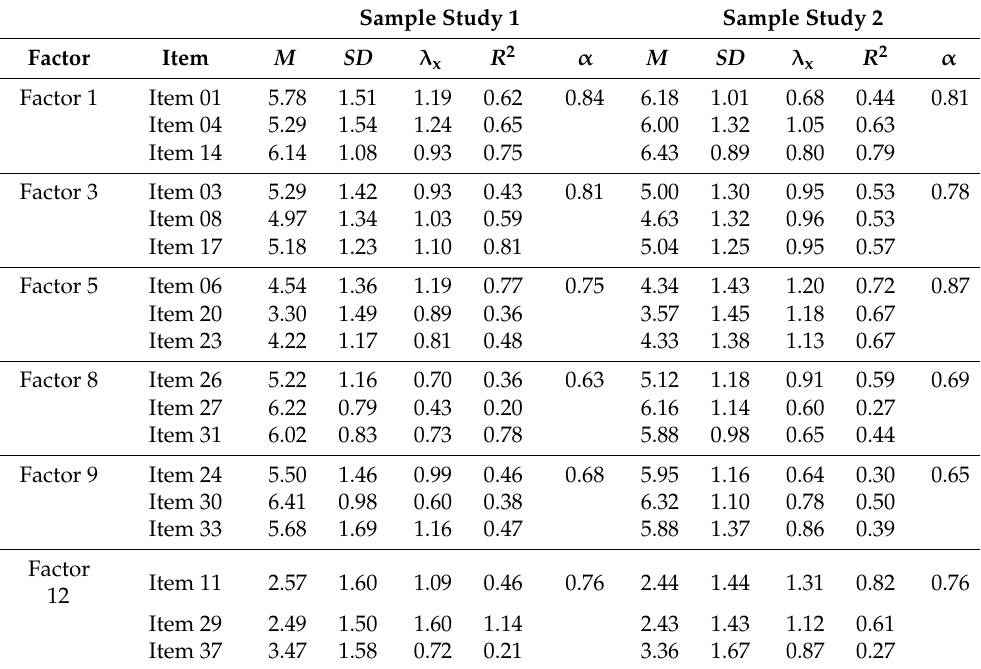
Table 1. Descriptives, confirmatory factor analysis estimations, and internal consistency coefficients for a six-factor model in university